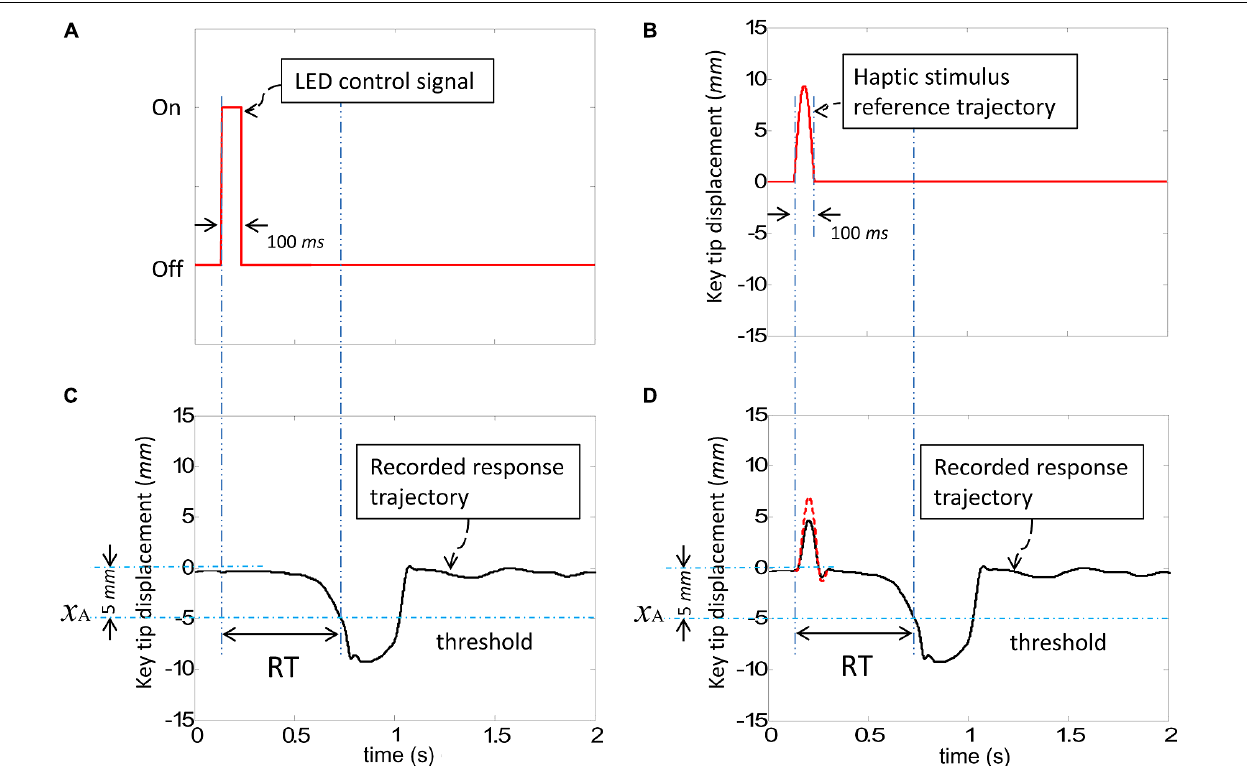
haptic stimulus (dashed line: without the finger resting on the key, solid line: with the finger resting on the key). Reaction time (RT) was defined as the difference between the initial stimulus command and the point at which the key crosses the threshold. Both visual and haptic stimuli were presented for a 100 ms time